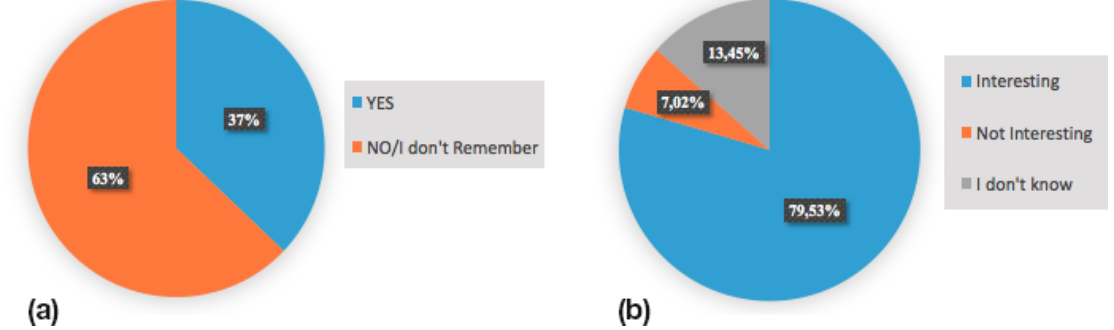
Figure 5. Users remembering at least one type of recommendations ( a ), and user perceptions of their interestingness ( b